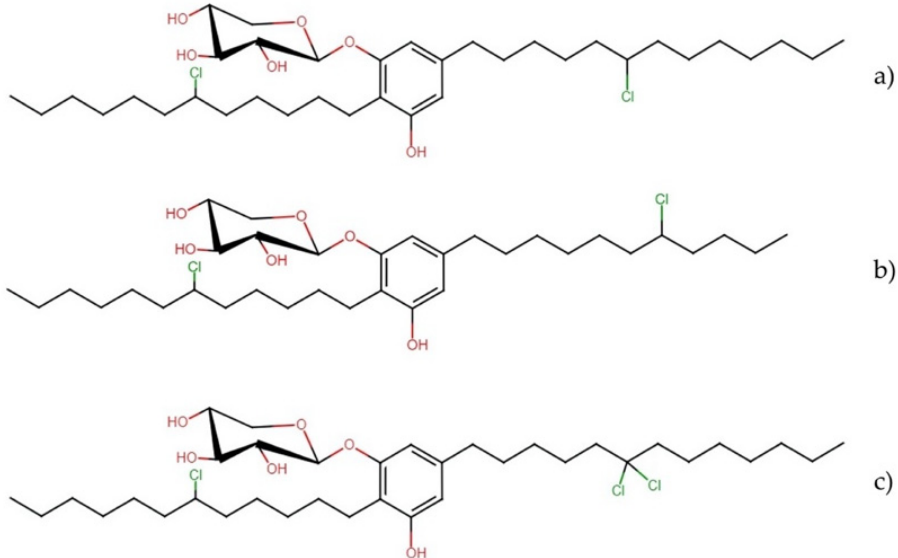
Figure 1. Chemical structures of bartolosides: ( a ) bartoloside A, ( b ) bartoloside E, and ( c ) bartoloside